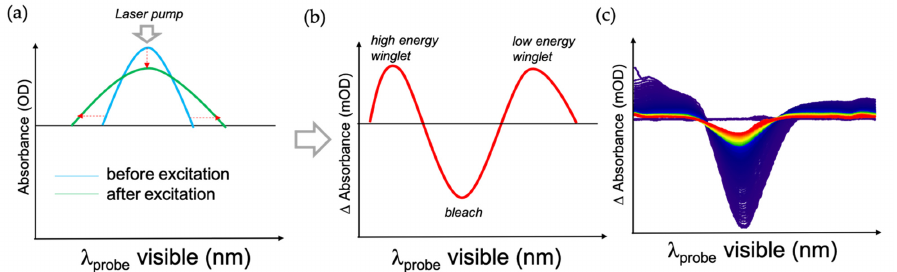
Figure 9. TAS measurement of plasmonic signal. ( a ) Schematic representation of the change in plasmonic absorption due to optical excitation; ( b ) different spectra measured in pump-probe; ( c ) example of data collected as a function of time (purple: shorter delay times, red: longer delay times).